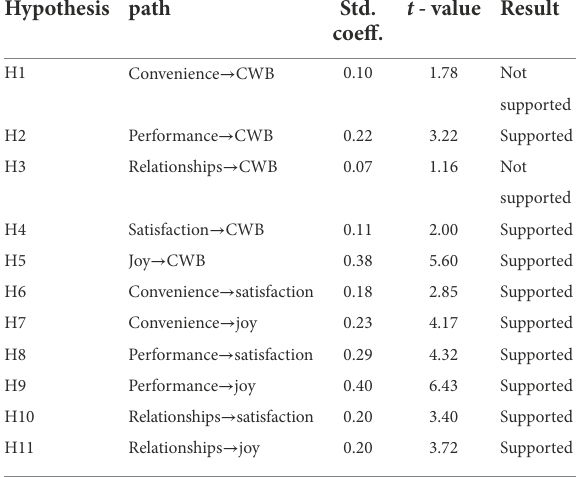
TABLE 5 Standardized path coefficients.